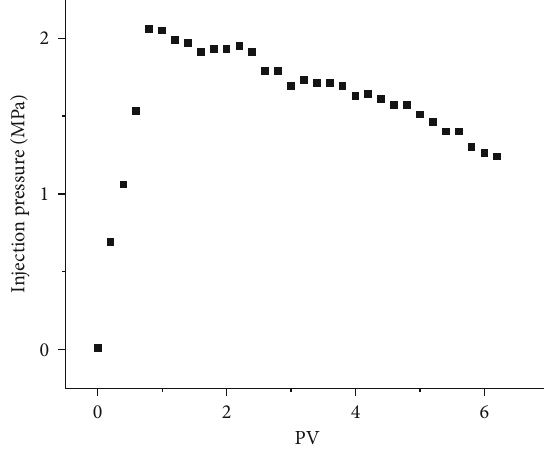
Figure 20: Plugging agent scour